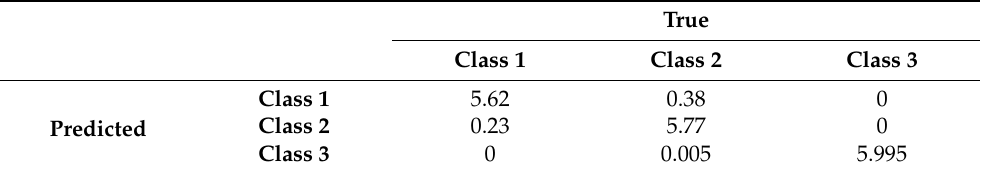
Table 5. Mean confusion matrix for SVM classifier with linear kernel.